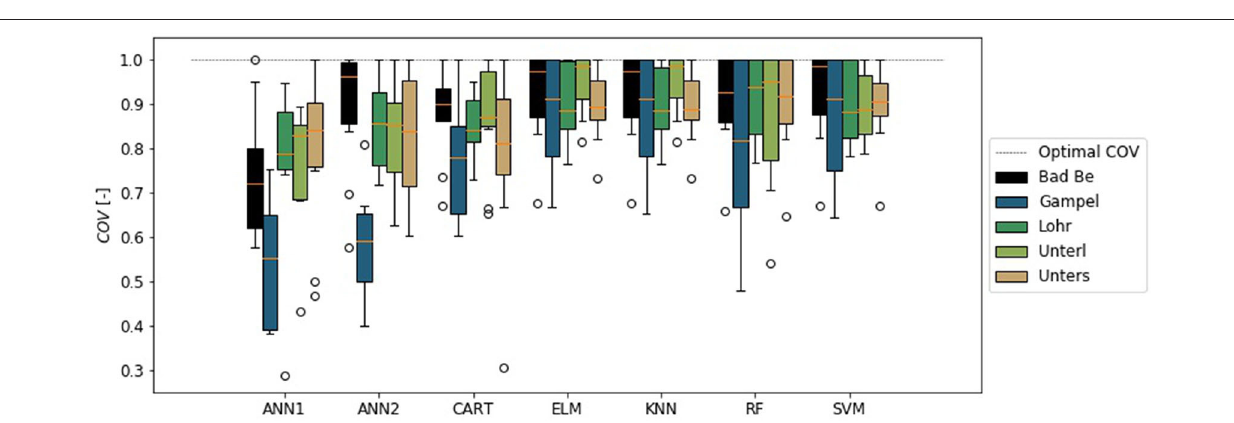
FIGURE 7 | Temporal coverage (COV) of the validation flood event duration in local application of trained artificial neuronal network with 1- (ANN1) and 2-hidden layers (ANN2), regression tree (CART), extreme learning machine (ELM), k-nearest-neighbor (KNN), random forest (RF), and support vector machine